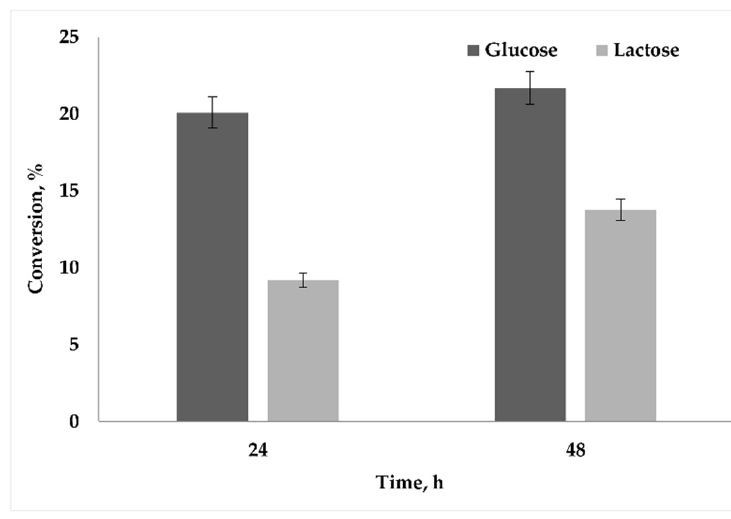
Figure 3. Consumption of glucose and lactose during the cultivation period.